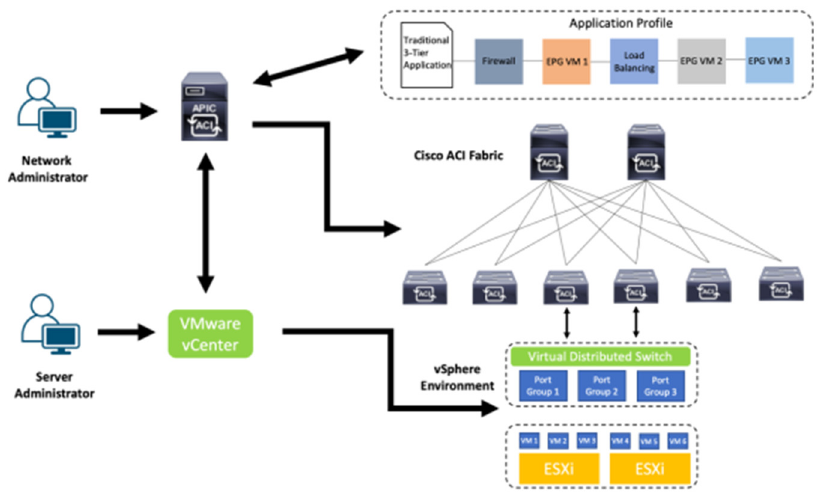
Figure 7. The proposed integration of SDN controller with NFV controller and management service.